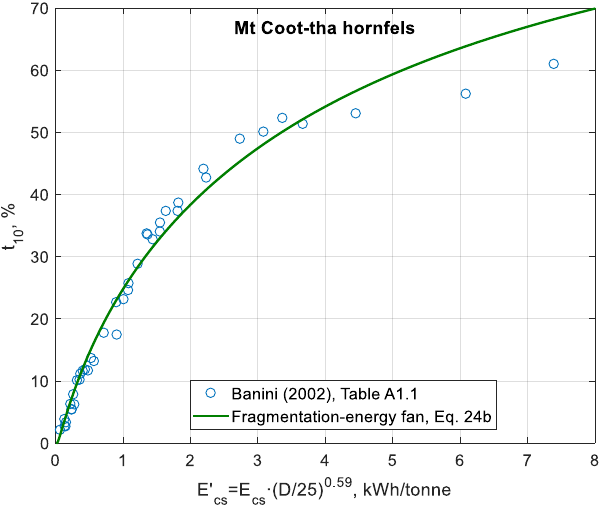
Figure 3. Breakage index equation 𝑡 10 (𝐸 𝑐𝑠′ ) , Equation (3), for Mt Coot-tha hornfels, based on frag- mentation energy fan (Figure 5 in [21]). Note that the non-linear regression that determined the fan parameters was made in the log-log space of Figure 2 whereas 𝑅 2 for the fan equation was obtained without any regression by comparing the resulting 𝑡 10 (𝐸 𝑐𝑠′ ) equation with the data in linear space. Table 1. Comparison of 𝑅 2 fitting fidelities of single and double fragmentation- energy fans with JKMRC’s size -dependent breakage model [22] for Banini’s [19] rocks.